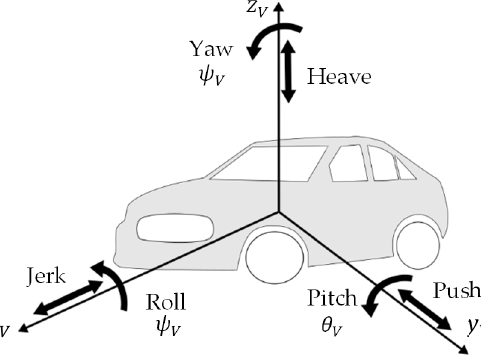
Figure 1. The six rigid body degrees of freedom of a vehicle.